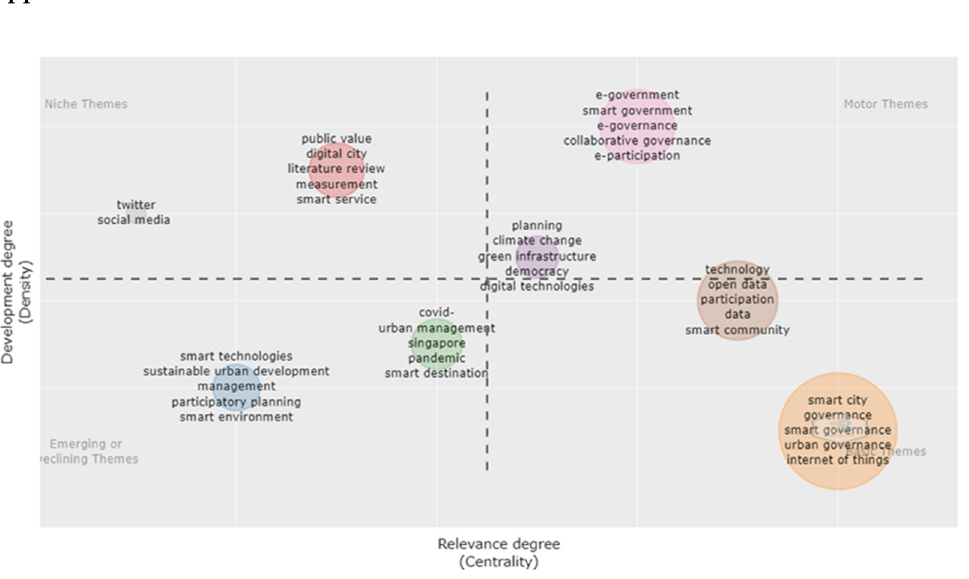
Figure A1. Thematic map of SPG smart city research.